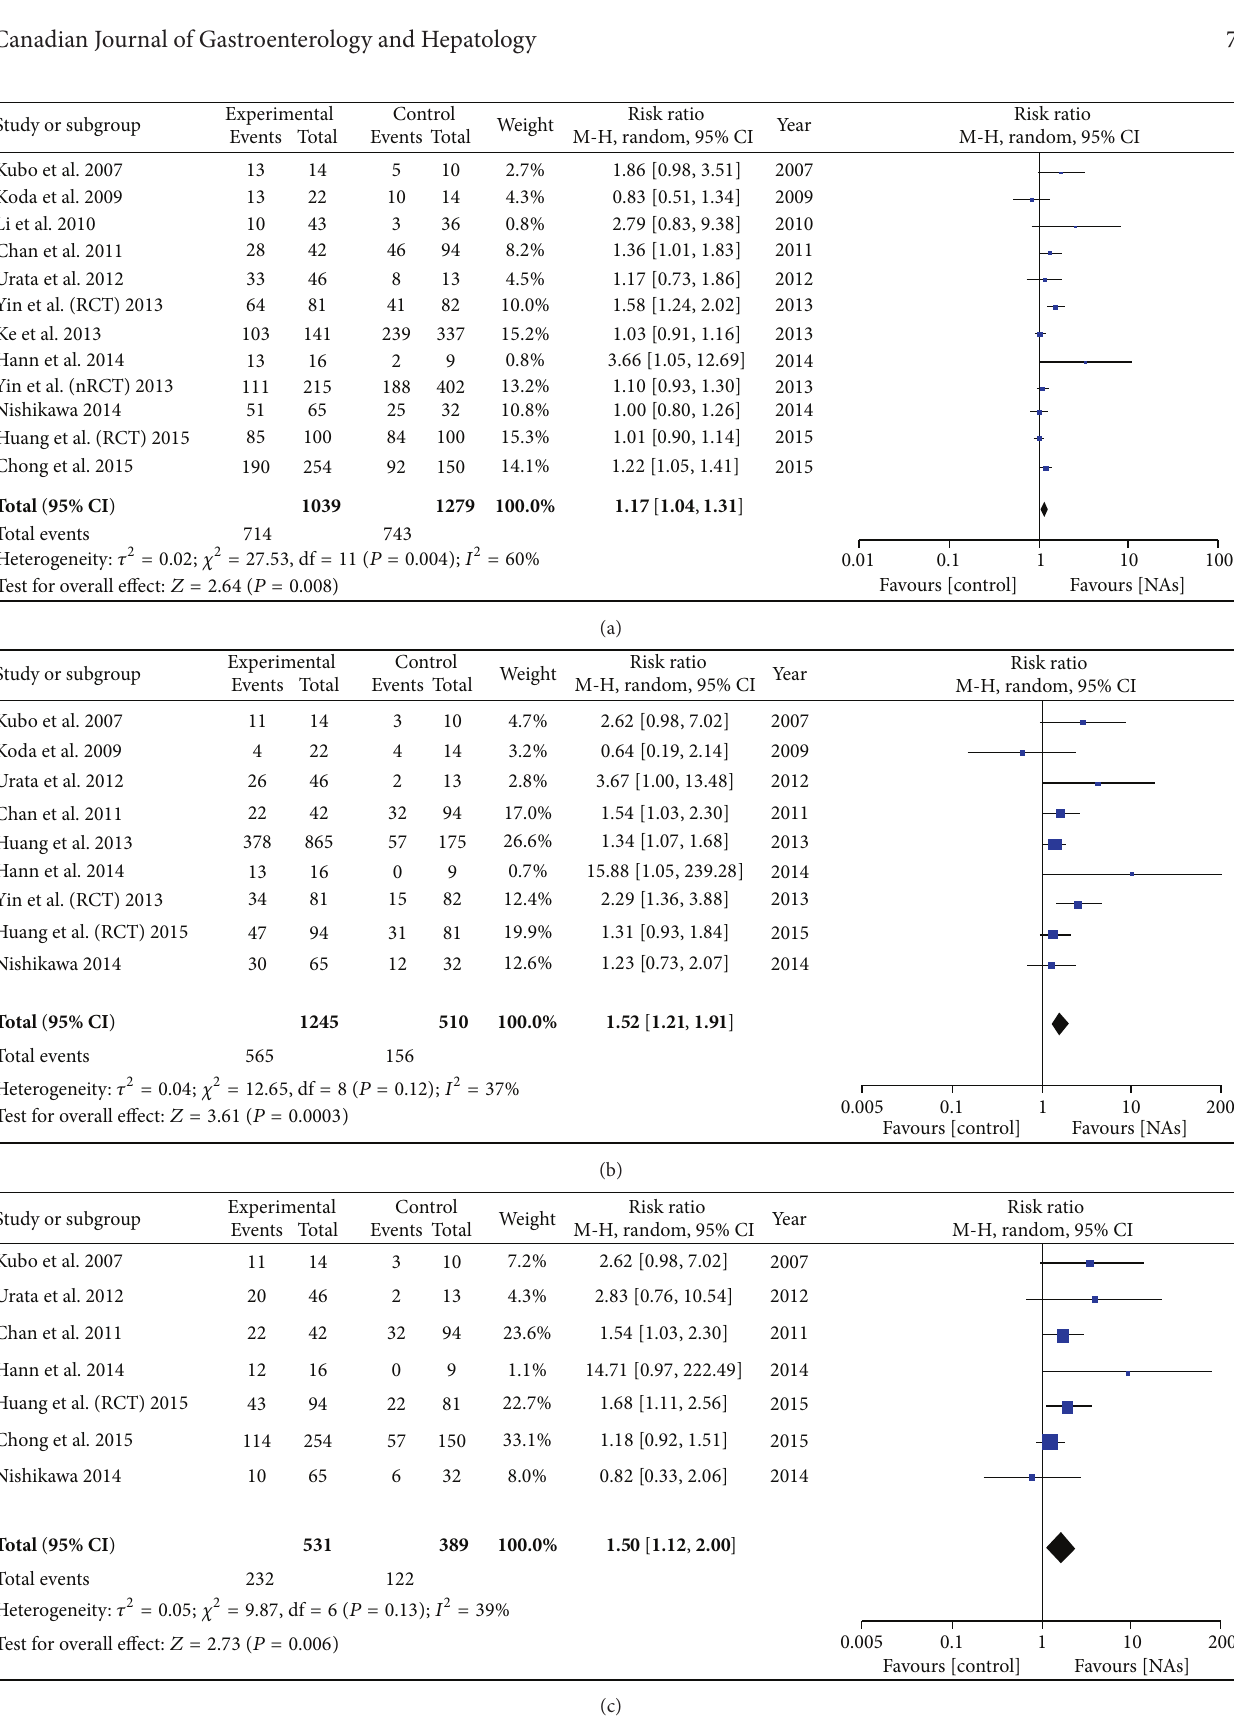
Figure 4: (a) Forest plot showing the impact of NAs on the 1-year DFS. (b) Forest plot showing the impact of NAs on the 3-year DFS. (c) Forest plot showing the impact of NAs on the 5-year